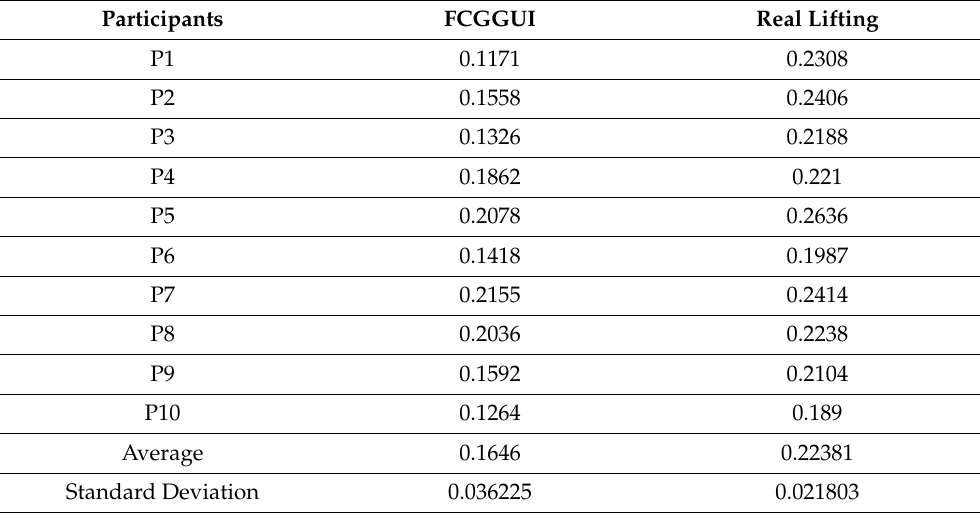
Table 11. Results of the average measured electromyogram.